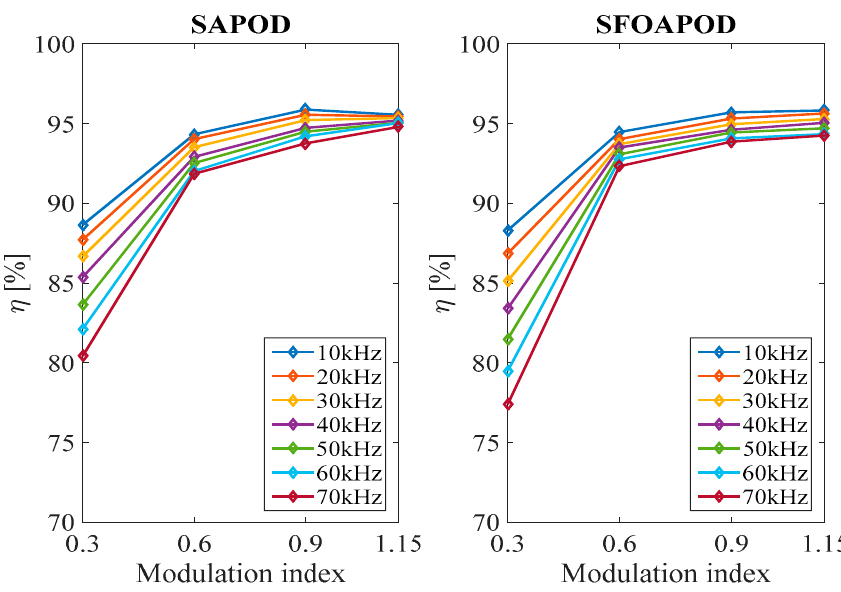
Figure 22. Experimental conversion efficiency trends of SAPOD and SFOAPOD schemes.